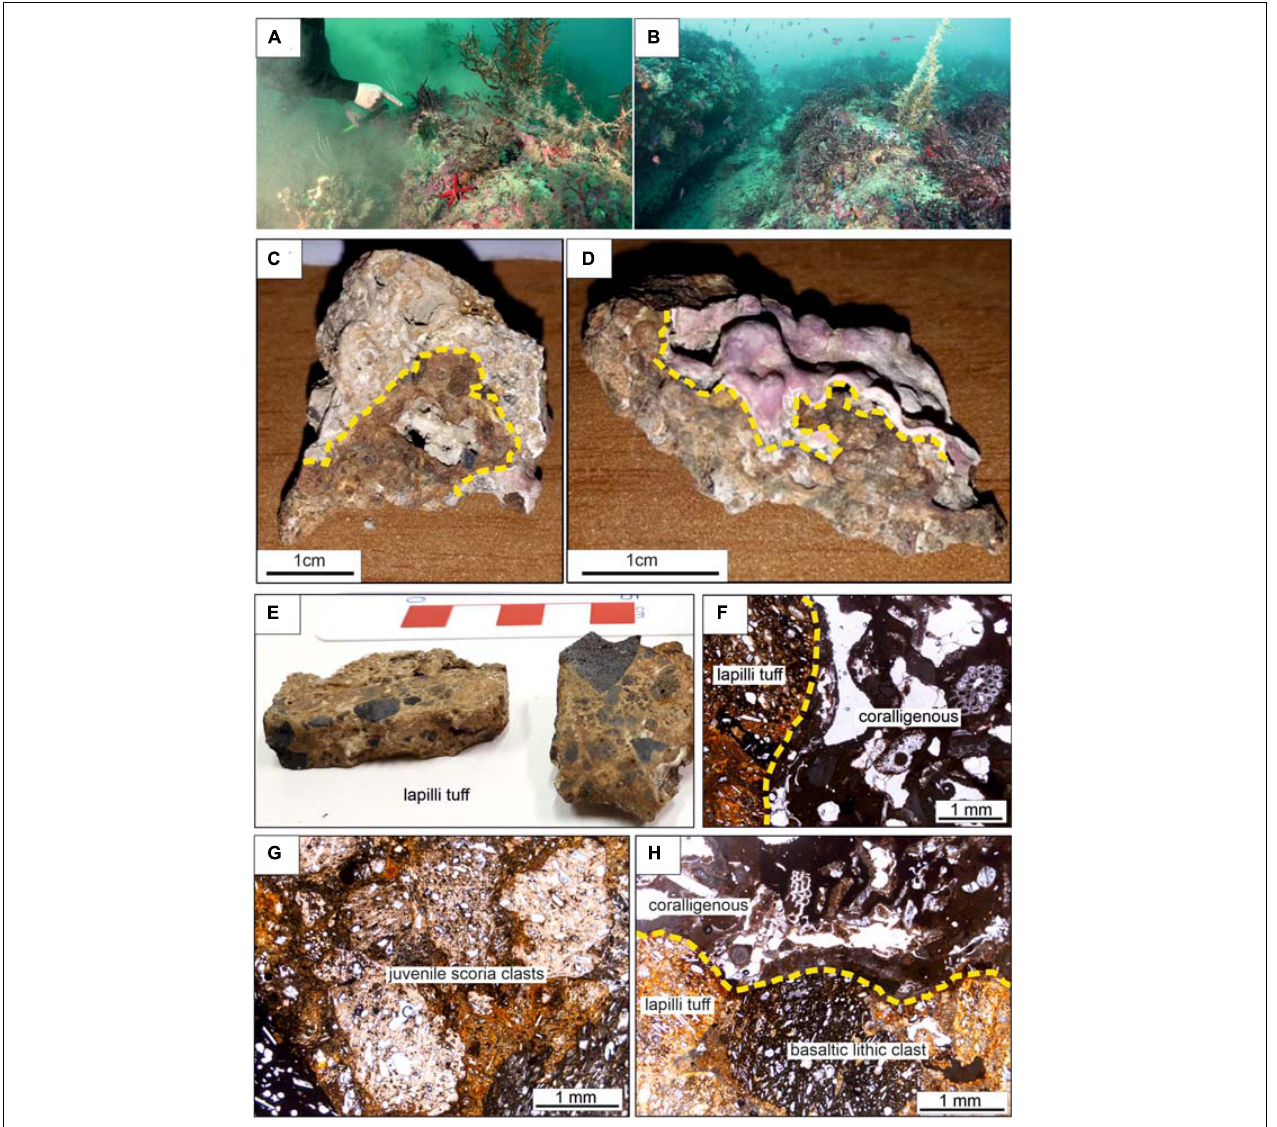
FIGURE 3 | (A) Underwater photo showing the site near the summit of the Actea volcano where the pyroclastic rock-encrusting coralligenous was sampled, as indicated by the diver. (B) Underwater photo of the top of the Actea volcano, densely colonized by benthonic communities. (C) Sample with the analyzed bioconstruction (coralligenous) grown on the lapilli tuff; the yellow dashed curve indicates the contact. (D) Pink coralline algae indicating the first deposition that over time leads to formations such as those of the sample in panel (C) . (E) Macroscopic features of two fragments of the lapilli tuff sampled at the summit of the Actea volcano. (F) Thin section photo (plane polarized light) of the lapilli tuff-encrusting coralligenous (yellow dashed line marks the contact). (G) Thin section photo (plane polarized light) of the lapilli tuff, emphasizing juvenile scoria clasts. (H) Thin section photo (plane polarized light) of a basaltic lithic clast in the lapilli tuff directly in contact with the coralligenous (yellow dashed line marks the